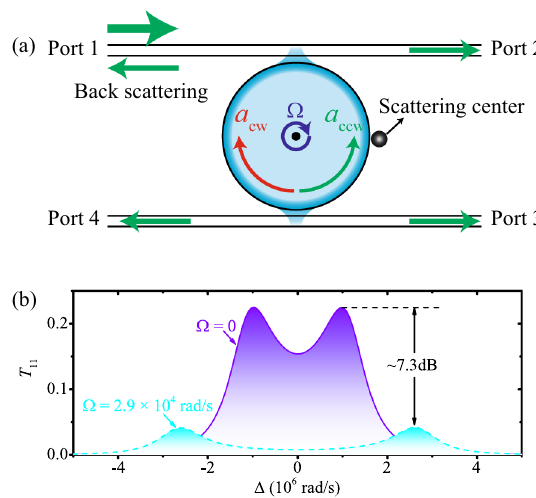
Figure 3. (Color online) ( a ) Schematic of the back scattering induced by a scattering center. ( b ) The back scattering spectra versus the detuning (cid:31) with J = 2 κ .